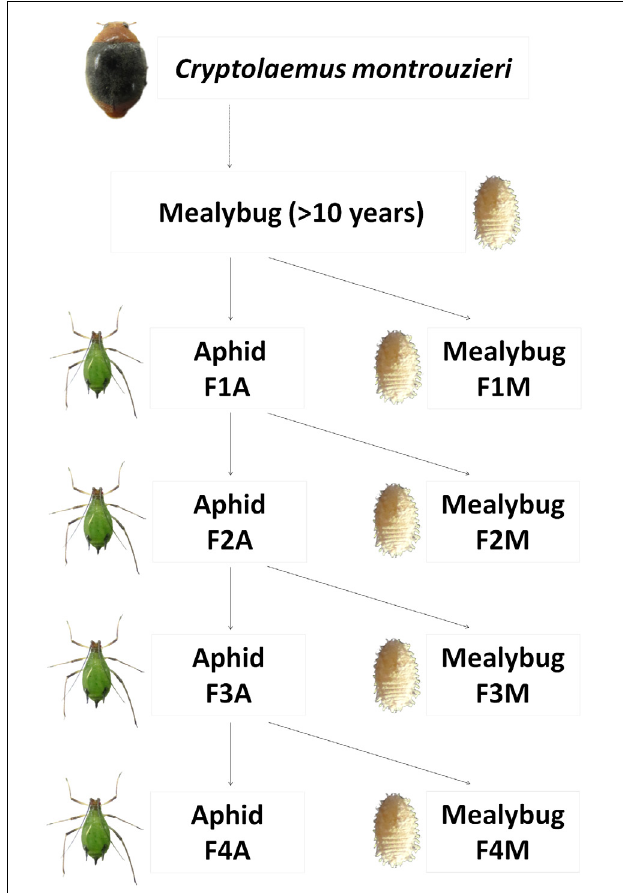
FIGURE 1 | Scheme of prey shifts in the evolutionary experimental approach applied in this study. Cryptolaemus montrouzieri ladybirds were reared on Planococcus citri mealybugs for more than 10 years ( ∼ 12 generations per year) and then allocated to two lines, either maintained on the alternative prey Megoura japonica aphids (F1A) or further reared on mealybugs (F1M). Freshly hatched larvae from F1A eggs were either shifted to mealybugs (F2M) or further reared on aphids (F2A). The lines F3M, F3A, F4M, and F4A were generated in a similar